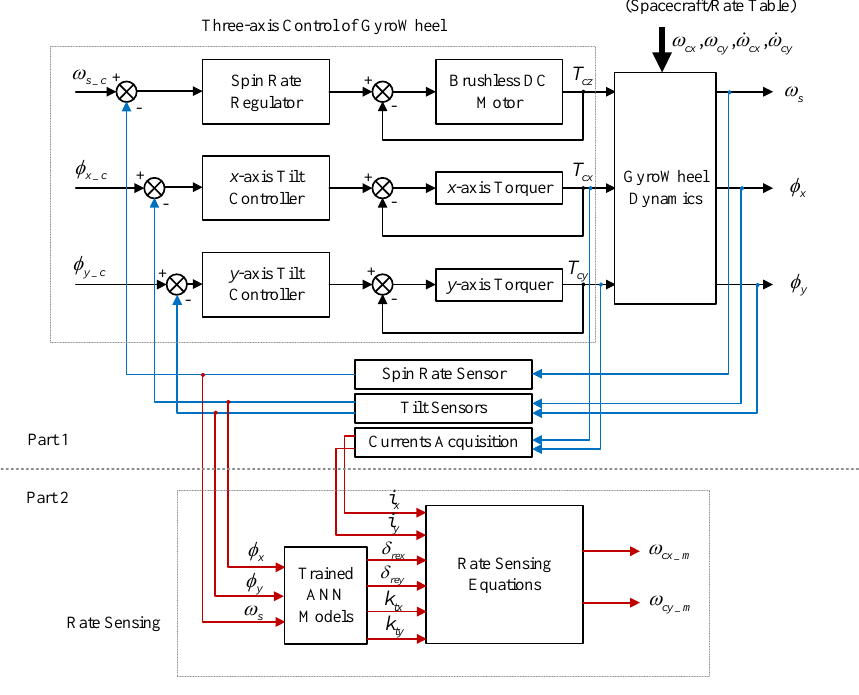
Figure 7. Schematic of the simulation platform.